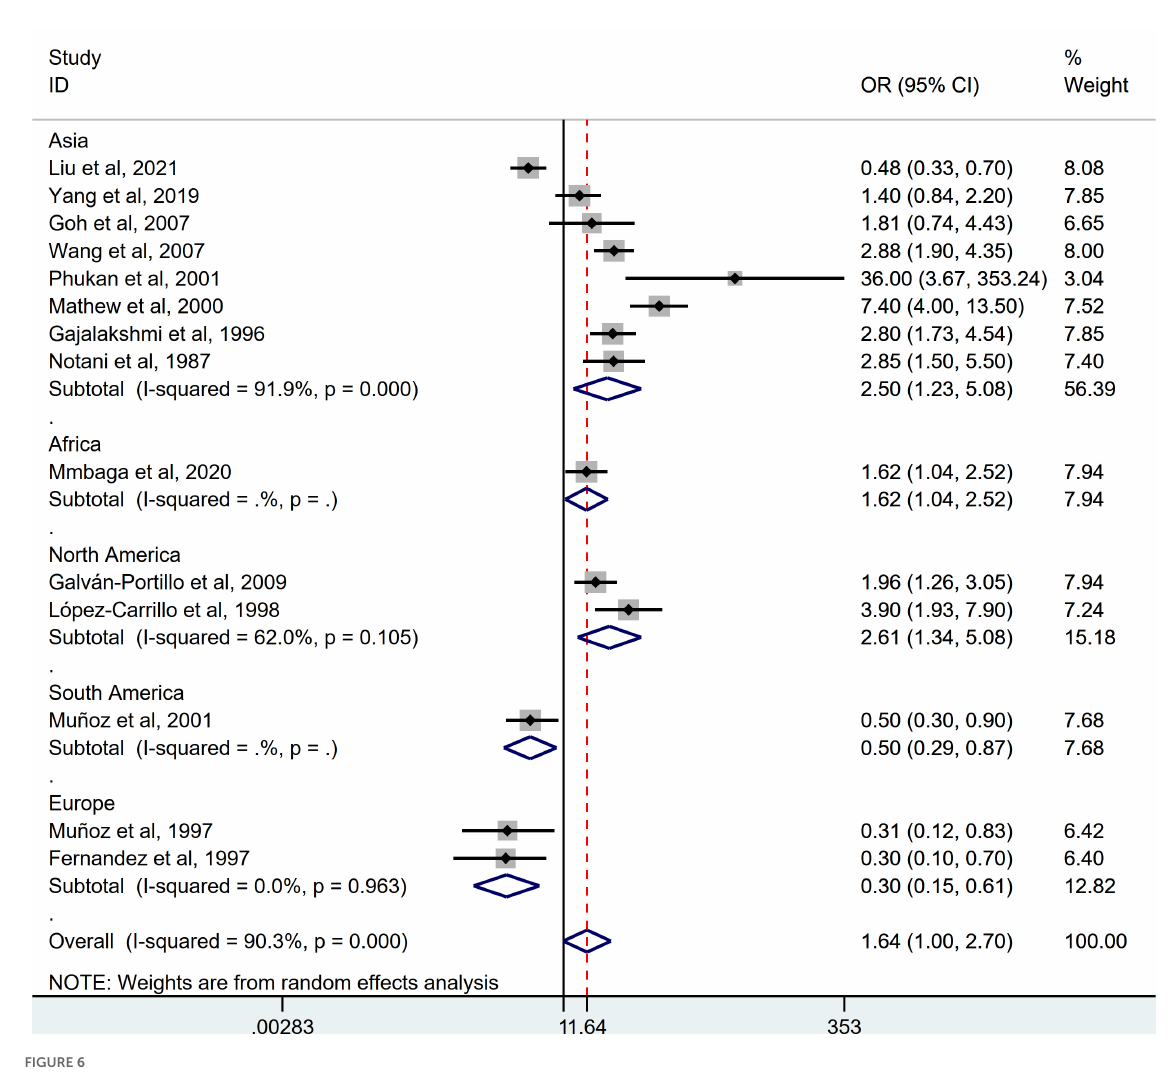
FIGURE6 Subgroup analysis showing associations between chili pepper consumption and the risk of GI cancers based on the region of the study. OR, odds ratio; CI, confidence